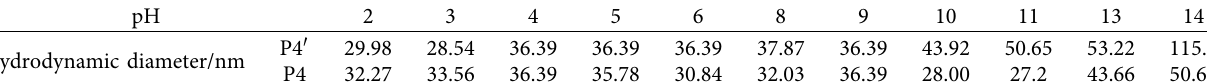
Figure 8: The value of I 540 nm / I 426 nm for P4 (a) and P4 ′ (b) as a function of pH. Table 1: DLS data of P4 and P4 ′ in water solution ([P4/P4 ′ ] � 10 μ M).